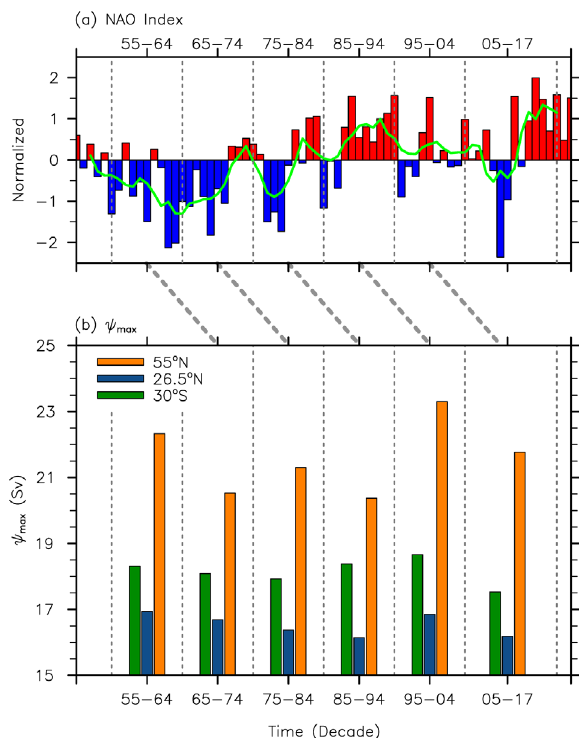
Fig. 3 Winter NAO index and AMOC. a Normalized winter (December- February) NAO index from 1950 to 2020. b The maximum AMOC volume transport at 30°S (green color bars), 26.5°N (blue color bars), and 55°N (dark orange color bars) in 1955 – 64, 1965 – 1974, 1975 – 1984, 1985 – 1994, 1995 – 2004, and 2005 – 2017. Green line in ( a ) indicates 5-year running averaged winter NAO index. Thin dashed lines in ( a ) and ( b ) mark the start and end of the decadal periods. Thick dashed lines between ( a ) and ( b ) link the NAO index with the maximum AMOC with 10-year time delay. Volume transports are in Sv